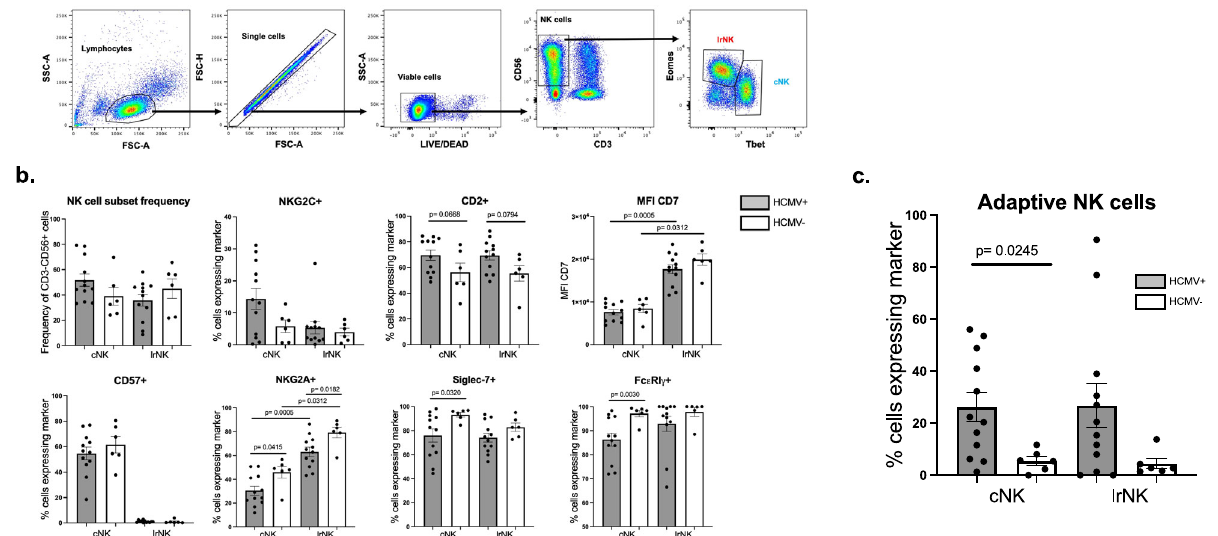
Fig.1|HCMVinfectionalterscNKandLrNKphenotypes.a NKcellsubsetswithin liverperfusates( n =18;12HCMV+,6HCMV-)couldbeseparatedintocNKandlrNK cellsbasedonexpressionofthetranscriptionfactorsTbetandEomesrespectively. b cNK and lrNK cells were further examined for their expression of surface mole- cules associated with adaptive NK cells (CD57, NKG2C, NKG2A, CD2, CD7, Siglec7 and Fc ε RI γ ). For all surface molecules except for CD7, frequencies of cells expressing the indicated molecule are shown. All cells were positive for CD7, so